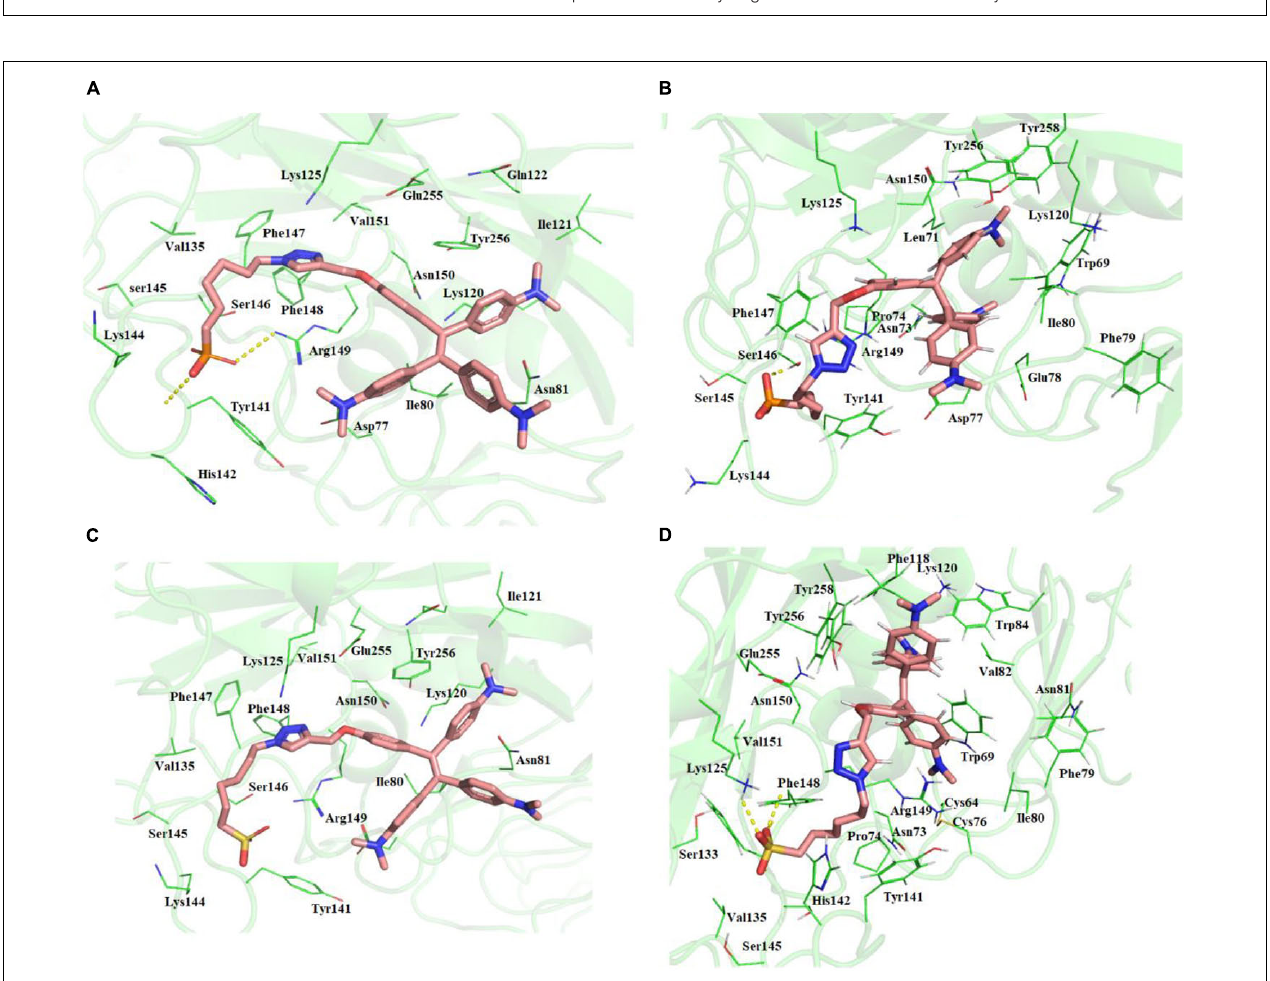
FIGURE 3 | (A) Molecular docking of TPE-P into the active site of the H5N1 hemagglutinin protein. (B) The average structure of the TPE-P bound H5N1 hemagglutinin protein extracted from the last 20 ns of total 100 ns of MD simulations. (C) Molecular docking of TPE-S into the active site of the H5N1 hemagglutinin protein. (D) The average structure of the TPE-S bound H5N1 hemagglutinin protein extracted from the last 20 ns of total 100 ns of MD simulations. The TPE-P and TPE-S molecules are shown in the stick model, and the amino acid residues are shown in line representation. The hydrogen bonds are shown in broken yellow lines.